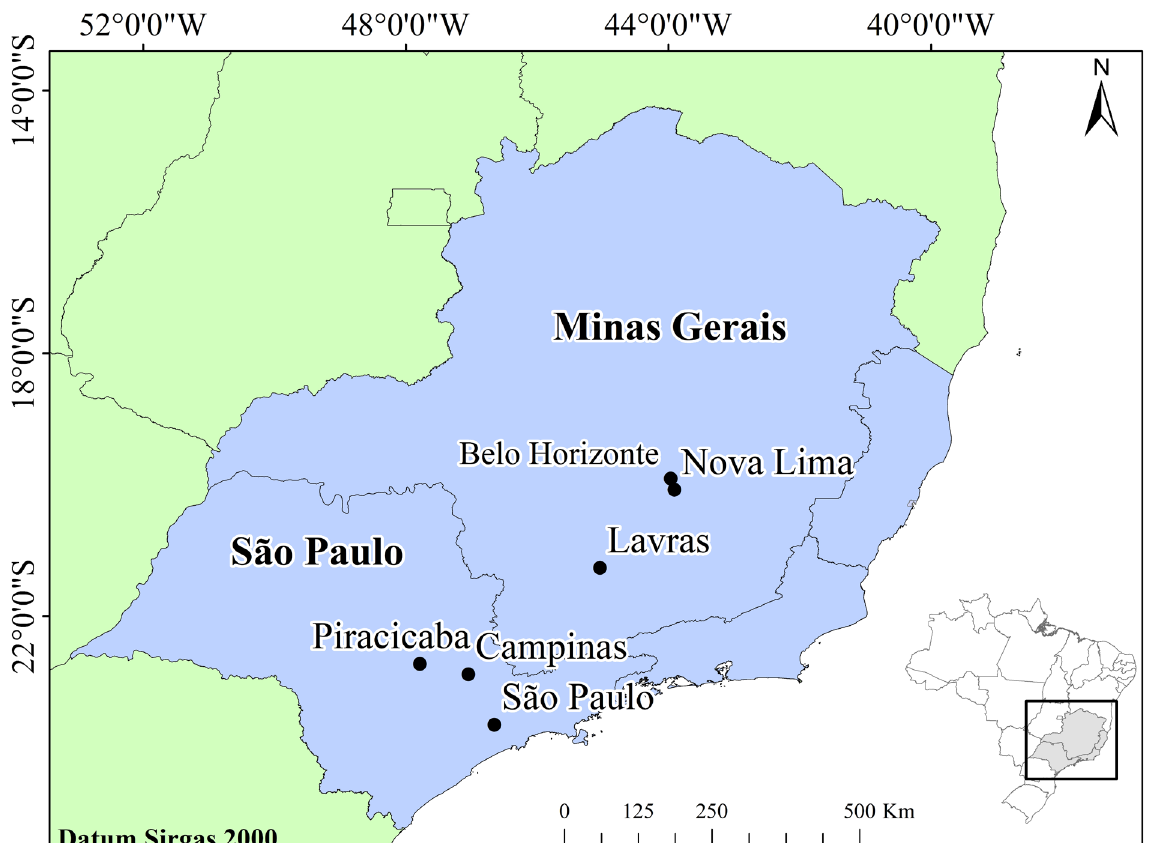
Figure 1. Location of the studied cities in Southeast,